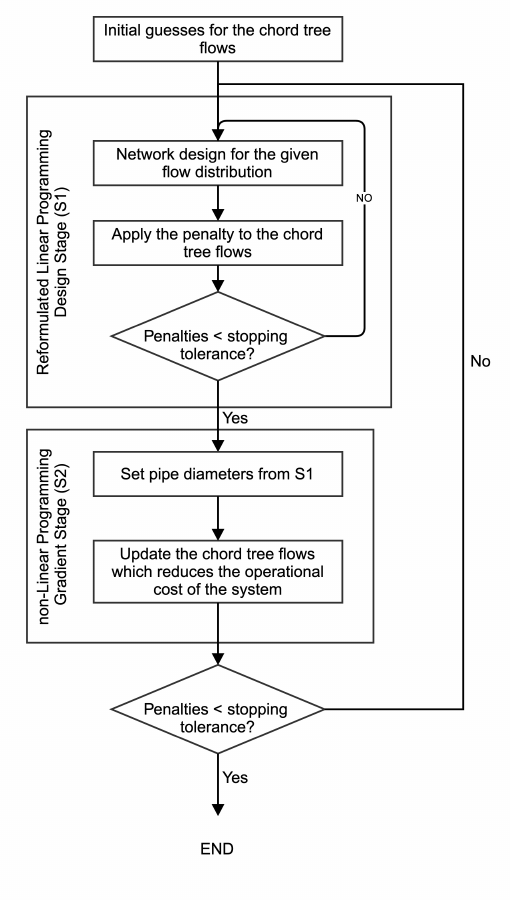
Figure 1. Flowchart of the proposed